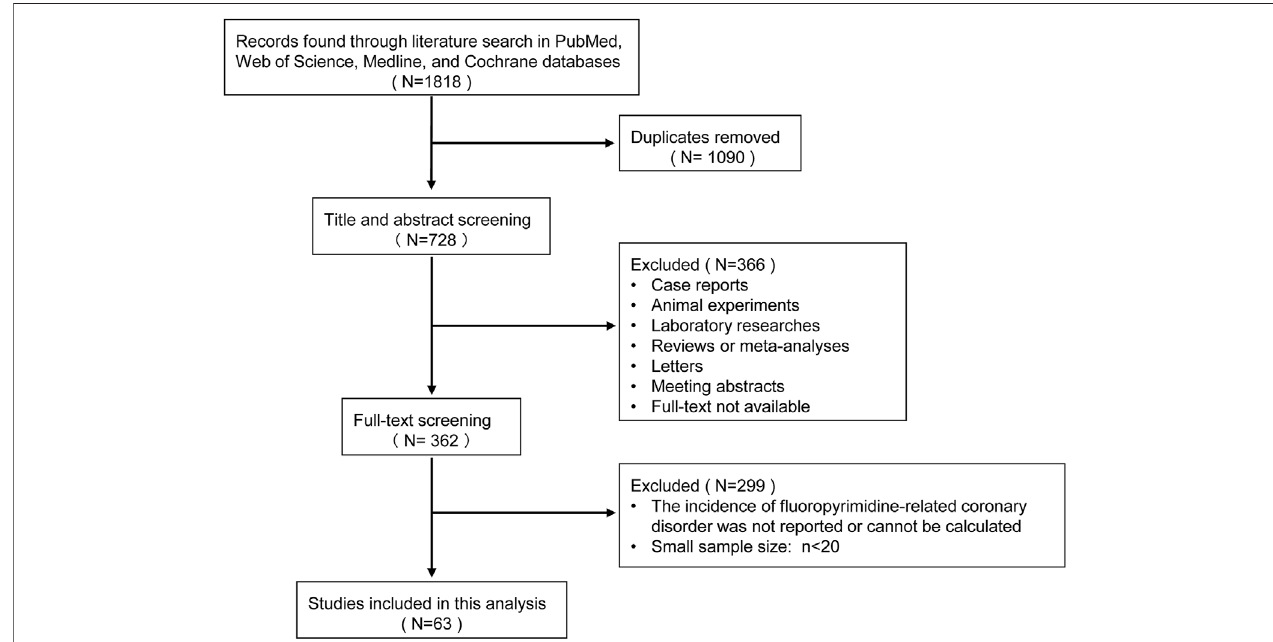
FIGURE 1 | The fl ow diagram for literature selection, screening, and